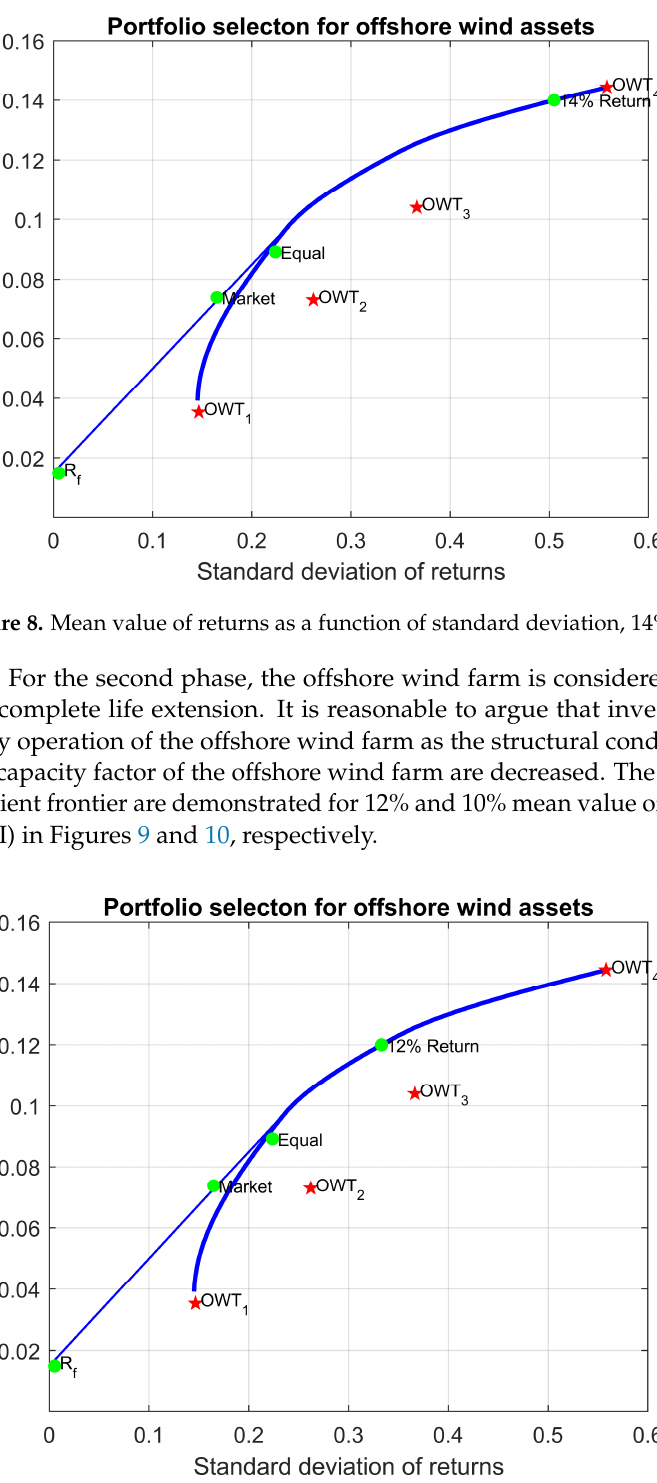
Figure 7. Mean value of returns as a function of standard deviation, 15% return and equal weights.